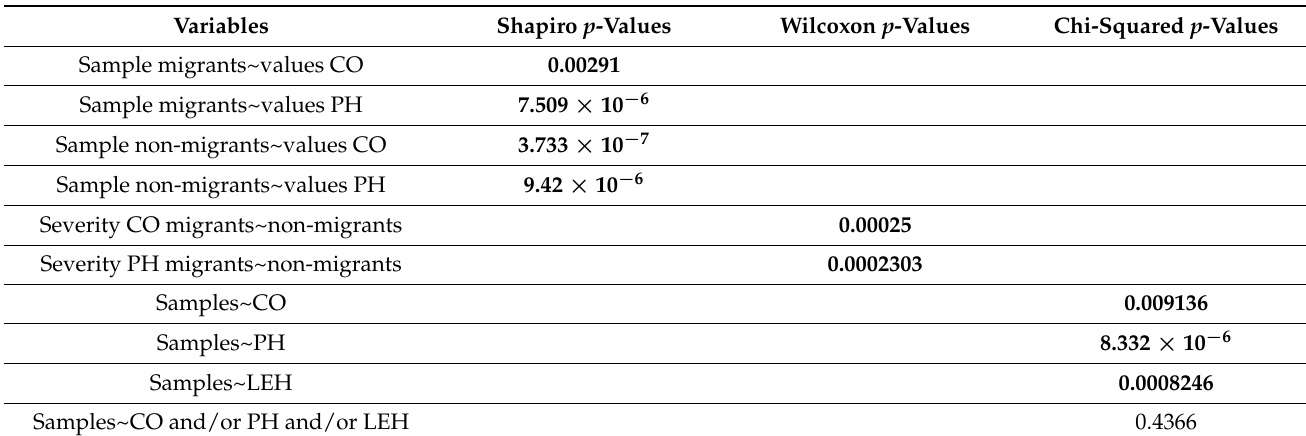
Table 4. Statistical analyses and p -values (significant p -values were bolded in the